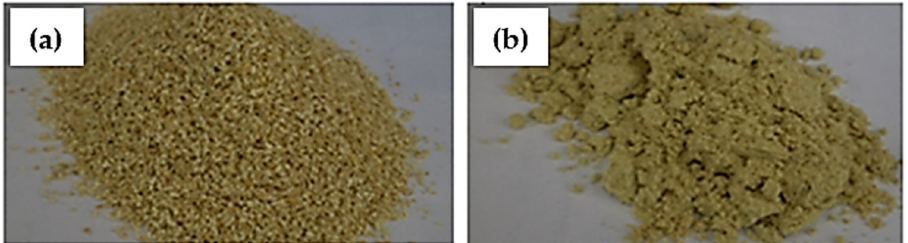
Figure 2. View of pumpkin seed hull fractions with their grain sizes ranging from ( a ) 0.6 to 0.8 mm and ( b ) 0.2 to 0.4 mm.